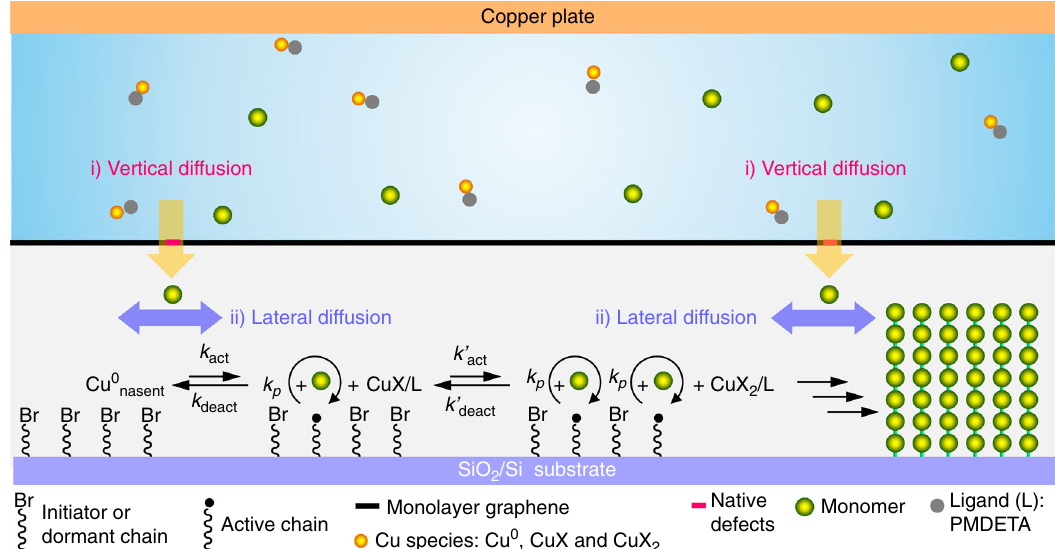
Fig. 6 Schematic description for the translocation of monomers at a graphene interface. Vertical translocation of monomers occurs at graphene native defects. After passing through the graphene, the monomers diffuse laterally under graphene